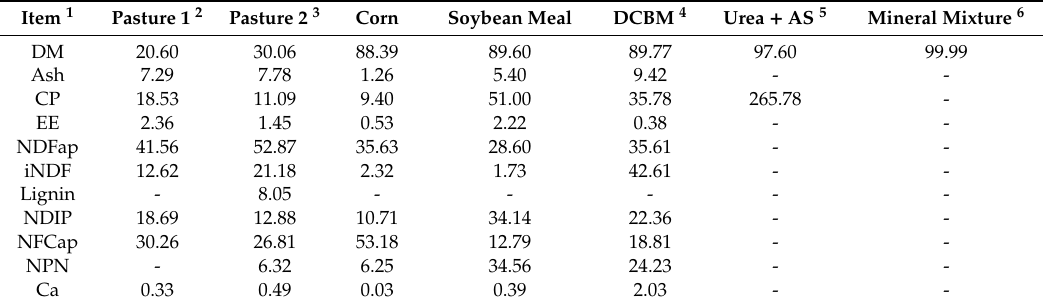
Table 1. Chemical composition of the ingredients used in the diets (% DM